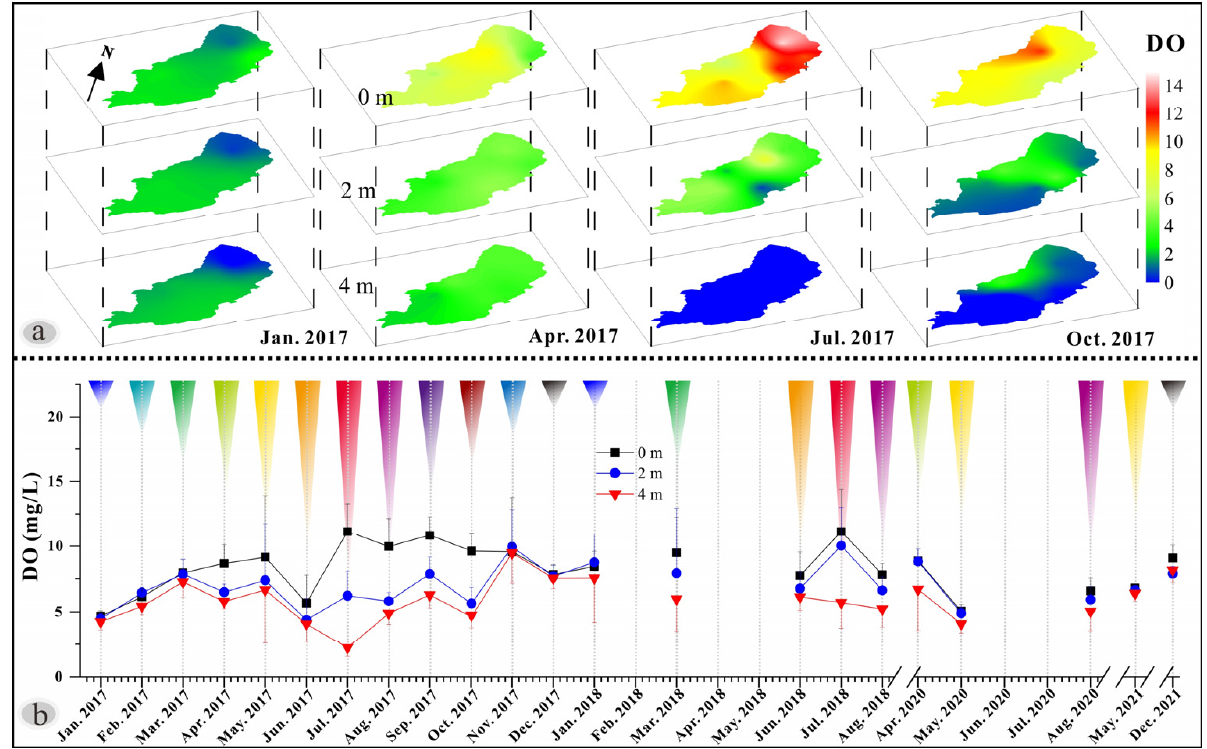
Figure 3. Seasonal and annual variations in dissolved oxygen in Lake QL. ( a ) Seasonal variations in dissolved oxygen; ( b ) Interannual variations in dissolved oxygen.